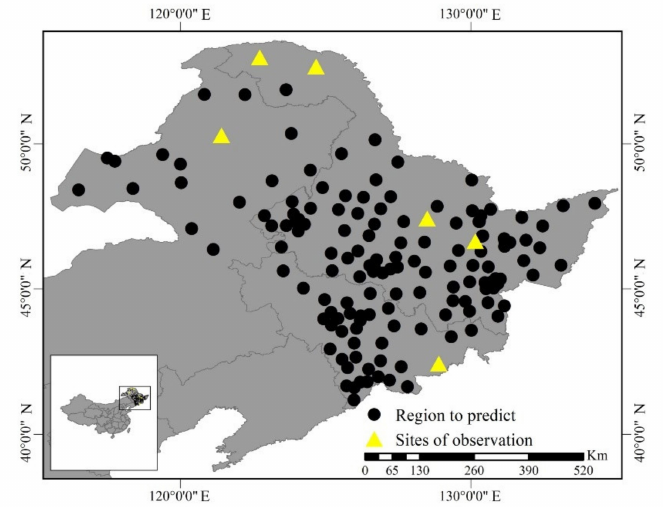
Figure 2. Study area in Northeast China for bog blueberry fruit-set